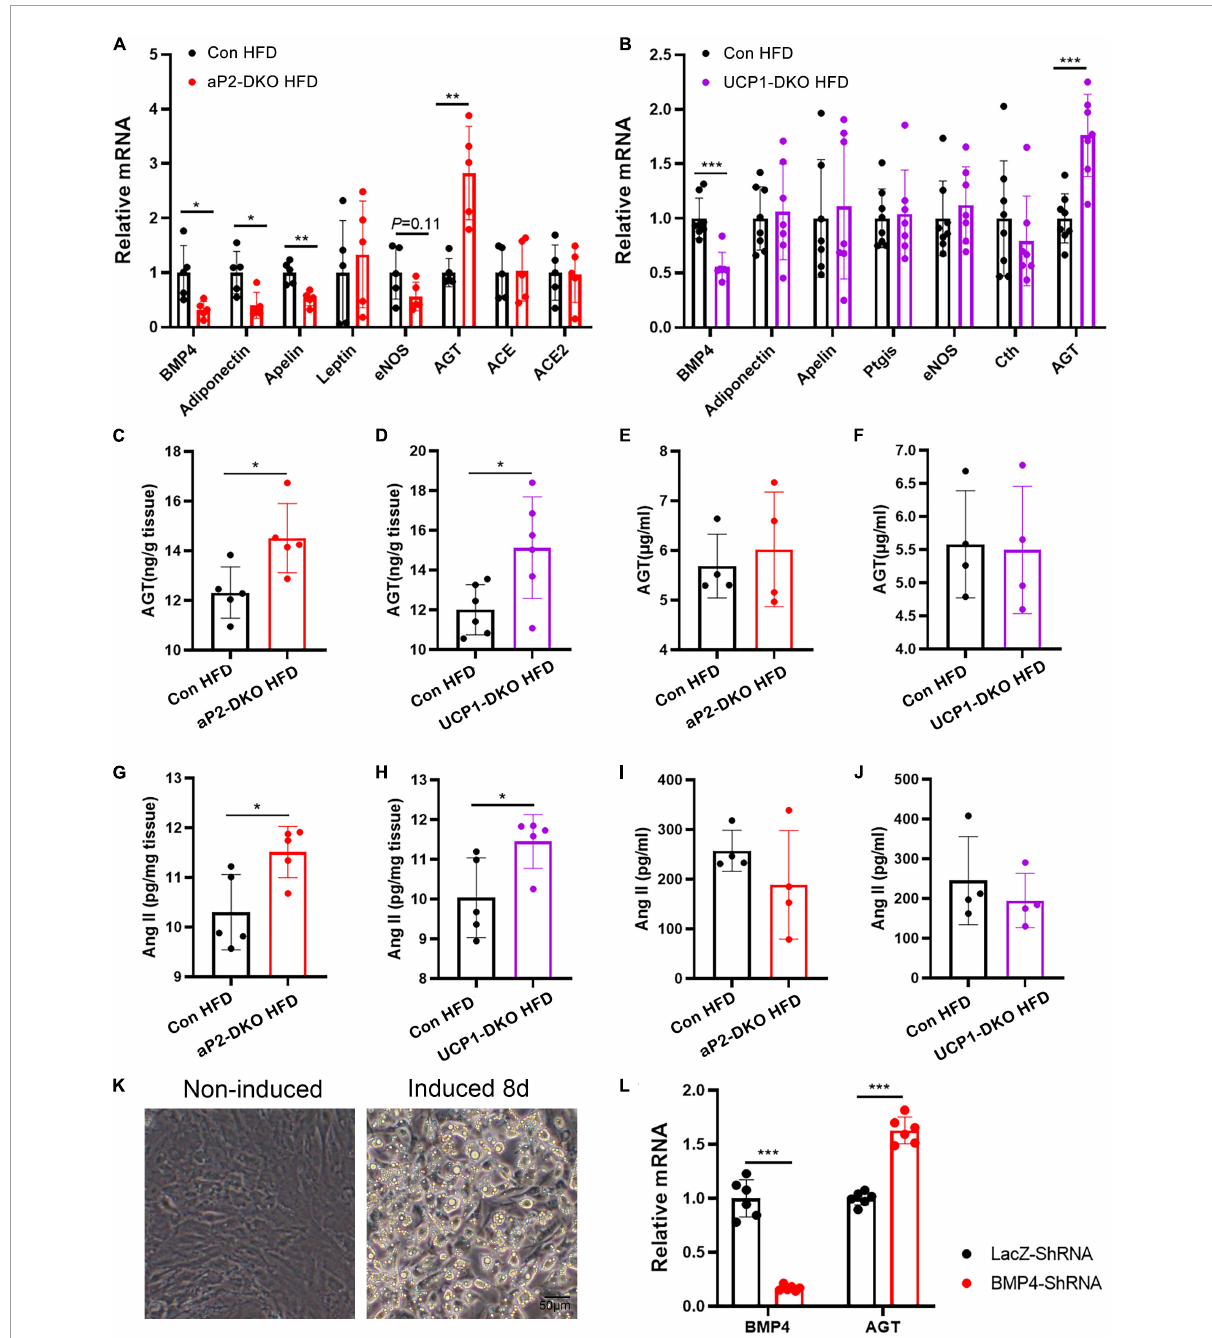
FIGURE6 Deficiency of bone morphogenetic protein 4 (BMP4) in perivascular adipose tissue (PVAT) activates local renin-angiotensin system. (A) Relative mRNA levels of BMP4 , Adiponectin , Apelin , Leptin , eNOS , Cth , AGT , ACE, and ACE2 in PVAT of the control and aP2-DKO mice ( n = 5). (B) Relative mRNA levels of BMP4 , Adiponectin , Apelin , Ptgis , eNOS , Cth, and AGT in PVAT of the control and UCP1-DKO mice ( n = 7–8). (C) AGT concentrations in PVAT from the control and aP2-DKO mice with 12-week HFD ( n = 5). (D) AGT concentrations in PVAT from the control and UCP1-DKO mice with 12-week HFD ( n = 6). (E) Plasma AGT concentrations in the control and aP2-DKO mice with 12-week HFD ( n = 4). (F) Plasma AGT concentrations in the control and UCP1-DKO mice with 12-week HFD ( n = 4). (G) Ang II concentrations in PVAT from the control and aP2-DKO mice with 12-week HFD ( n = 5). (H) Ang II concentrations in PVAT from the control and UCP1-DKO mice with 12-week HFD ( n = 5). (I) Plasma Ang II concentrations in the control and aP2-DKO mice with 12-week HFD ( n = 4). (J) Plasma Ang II concentrations in the control and UCP1-DKO mice with 12-week HFD ( n = 4). (K) Image of PV1 induced or non-induced to mature adipocytes. (L) Relative mRNA levels of BMP4 and AGT in PV1 with BMP4 knockdown or lacZ knockdown. Values are means ± S.E.M. * P < 0.05, ** P < 0.01, and *** P < 0.001 by unpaired Student’s t -test (A–J,L)